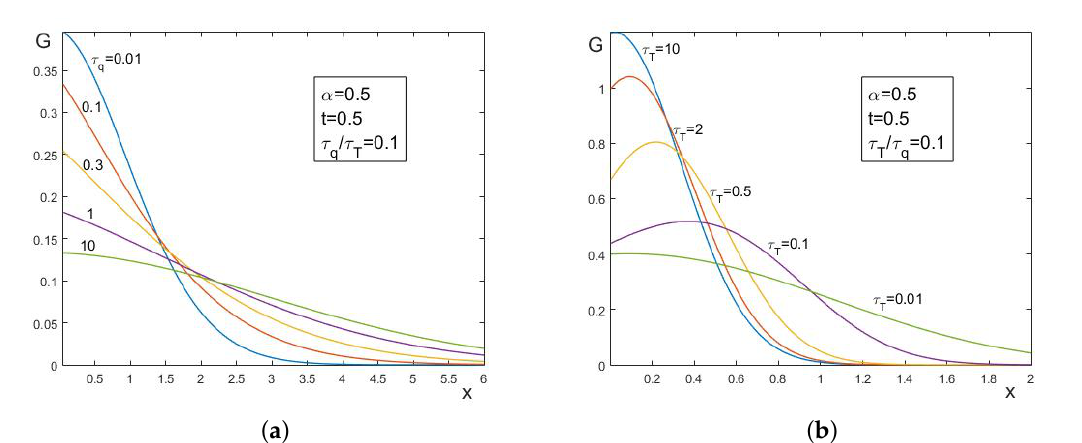
Figure 3. Plots of the fundamental solution G 1 ( x , t ) versus x ( x > 0) for different values of the relaxation times τ q and τ T : ( a ) τ q / τ T = 0.1—diffusion regime; ( b ) τ T / τ q = 0.1—propagation